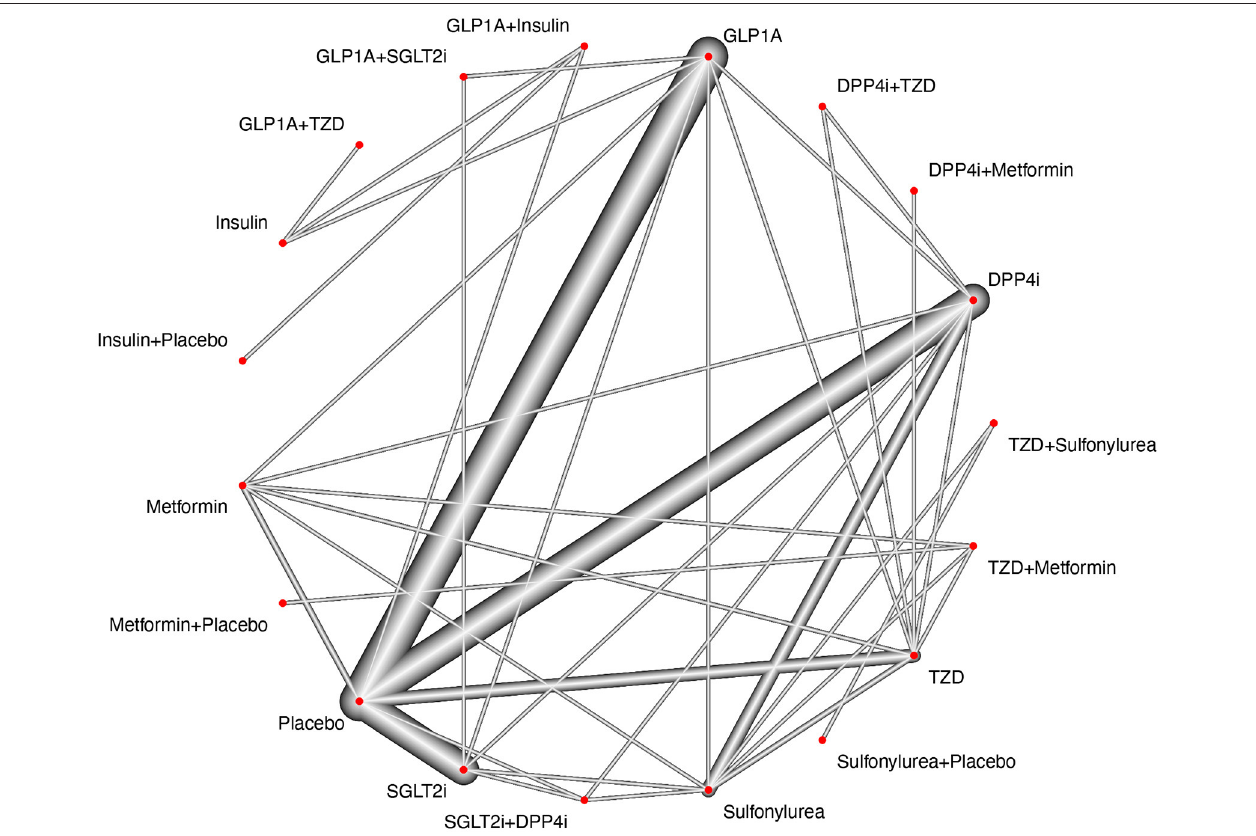
FIGURE 2 | Study network. The study network presents sharp connections between placebo vs. GLP1-RA, placebo vs. SGLT2i, placebo vs. DPP4i and placebo vs. TZD (pioglitazone). The nodes for Sulfonylurea, TZD, DPP4i, GLP1-RA, SGLT2i are also tightly connected with most treatment arms, however, it is possible to observe a poor connection between drug combinations (SGLT2i + GLP1-RA, GLP1-RA1 + Insulin, SGLT2i + DPP4i, GLP1-RA + TZD, etc) and other treatment arms. By using additive component network meta-analysis, it is possible to account for both single treatments and combinations, but the combinations may be more prone to depend on the effect of indirect comparisons if paralleled to single treatment comparisons.